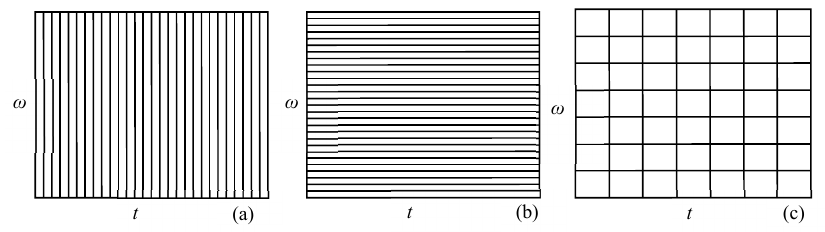
Figure 3. Schematic illustration of the time/frequency windows associated with the basis function for the following linear transforms: ( a ) Dirac- δ transform, ( b ) Fourier transform and ( c ) windowed Fourier transform.